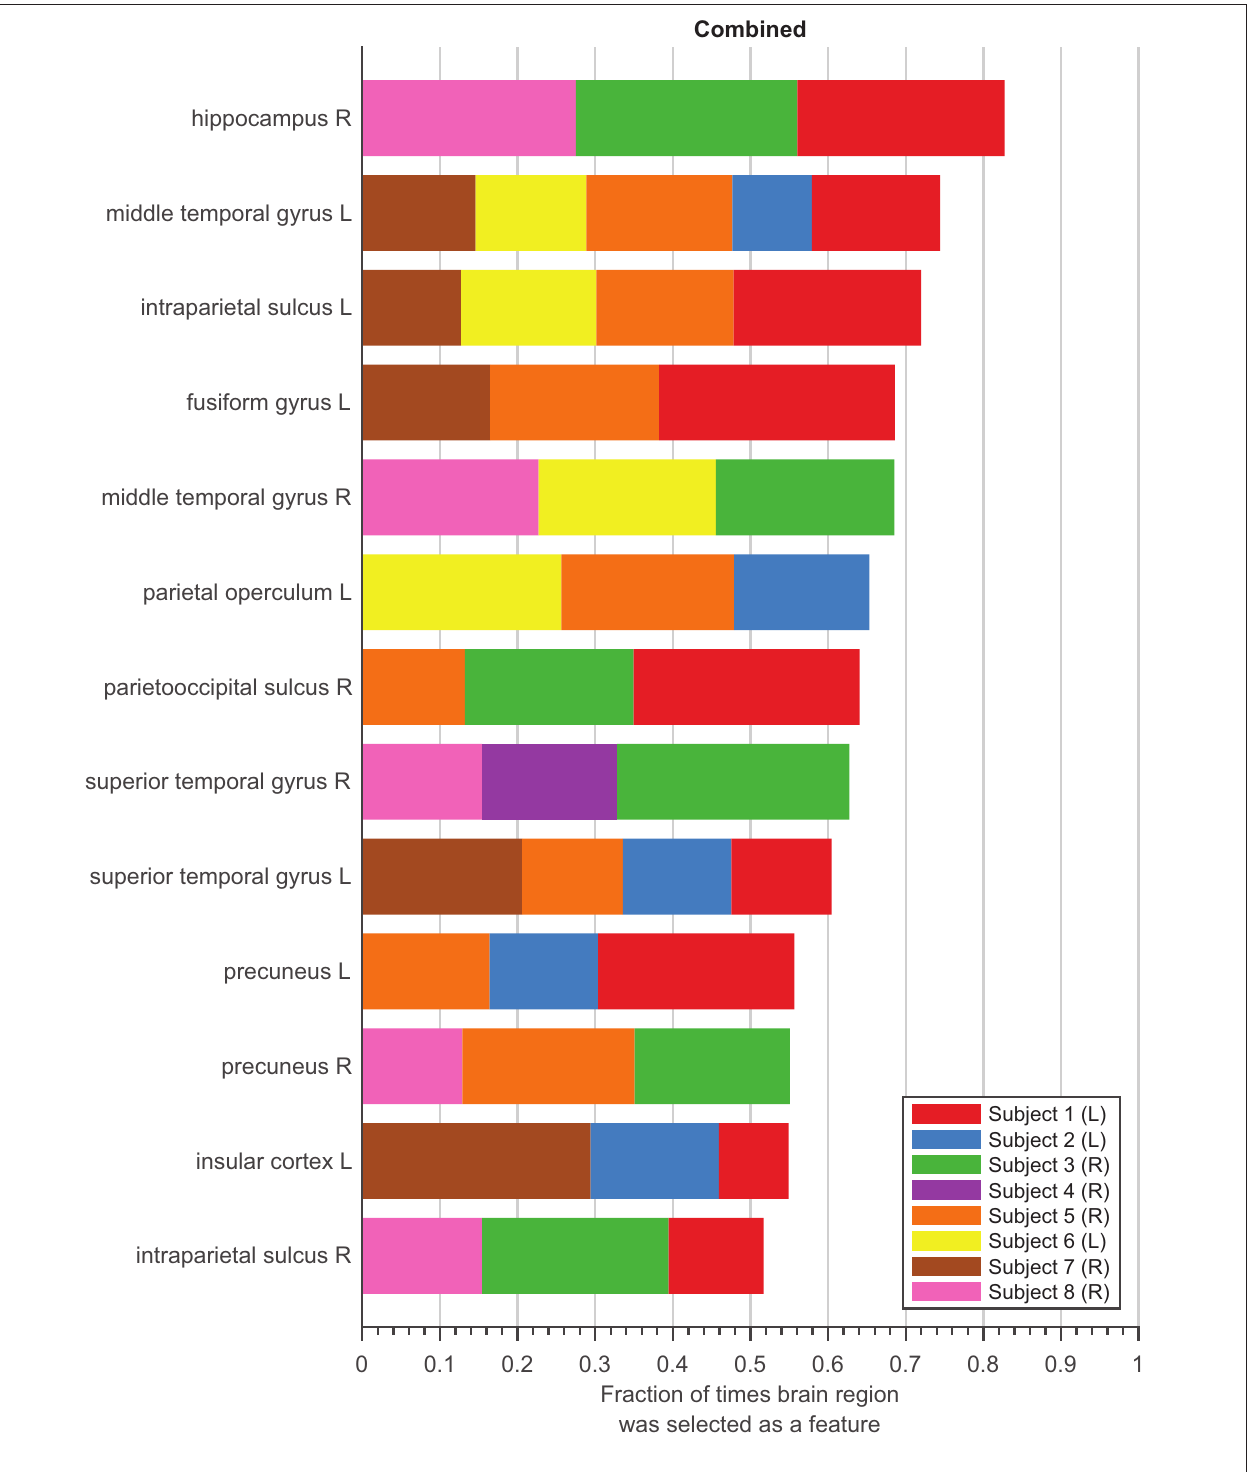
FIGURE 5 | Stability Analysis. Stability of features in the combined models for eight subjects, sorted by the fraction of times feature was picked during feature selection relative to the 100 iterations during 10-fold cross-validation. Each subject is denoted as a different color bar. Length of each colored bar represents the fraction of times feature was selected relative to the total number of times feature was sampled within each subject. Only features that were selected as a final feature are shown.